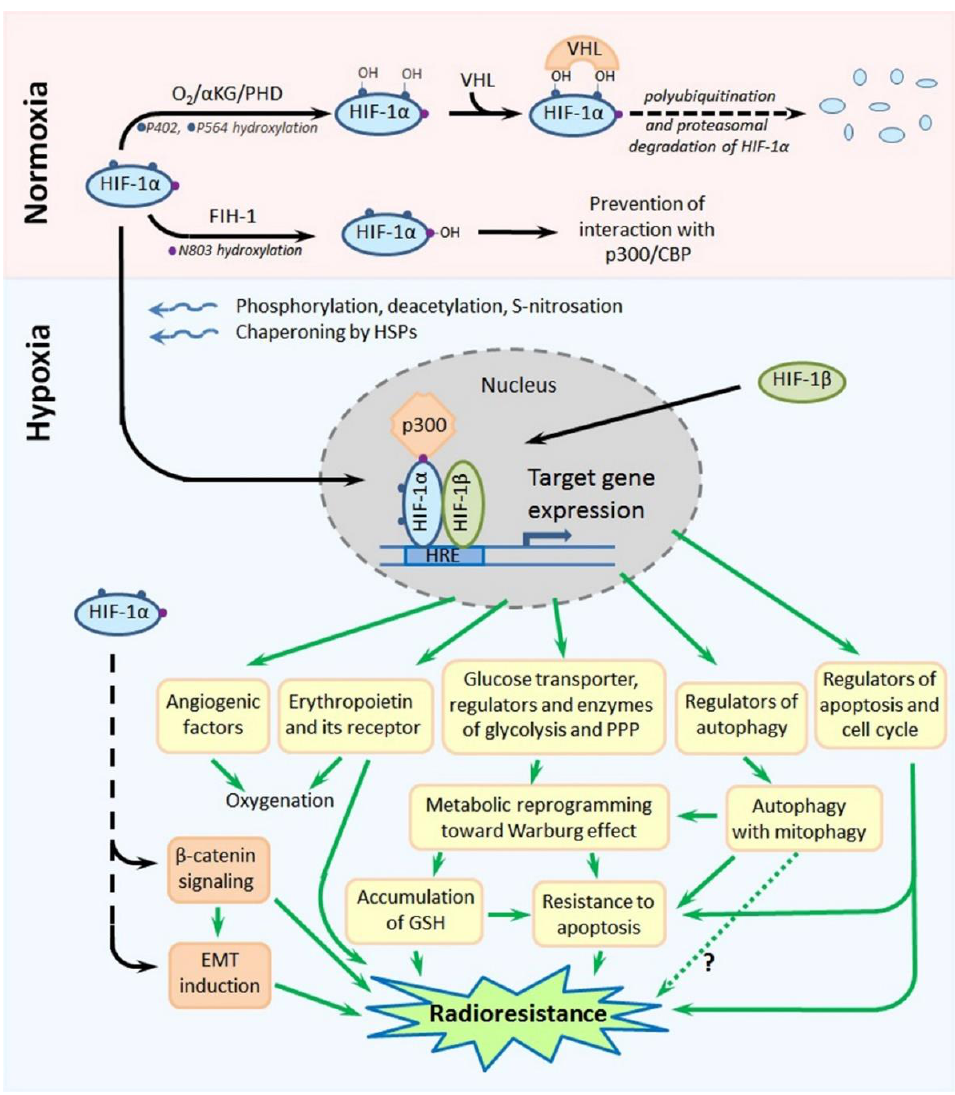
Figure 4. Scheme showing the major mechanisms of regulation of the stability and functional activity of HIF-1α and, also, the major HIF-1α-mediated pathways leading to the radioresistance of hypoxia-adapted cancer cells. Details are given in the text. Abbreviations: HIF-1α—hypoxia-inducible